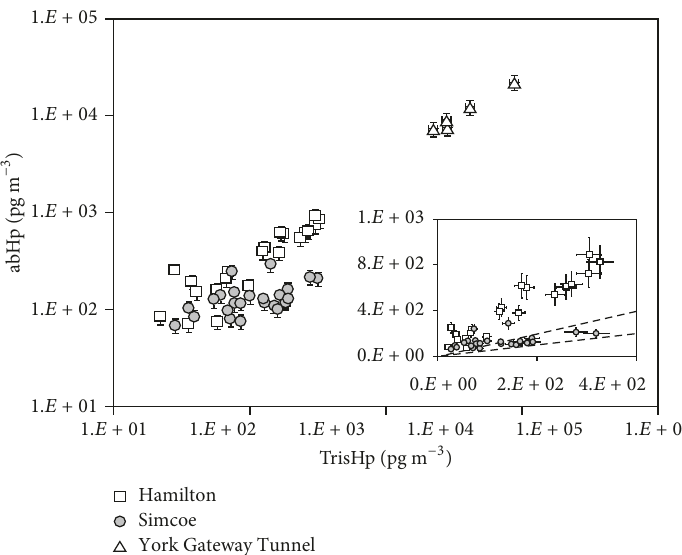
Figure 3: Scatter plot of 𝛼 , 𝛽 -hopane (abHp) concentration versus trisnorhopane (TrisHp) concentration in PM 10 collected at three different locations. The figure is in logarithm scale, and the inset is in expanded linear scale. The linear regression slopes for the Hamilton, Simcoe, and York Gateway Tunnel samples are 2.6 ± 0.1 ( 𝑟 2 = 0.884), 0.89 ± 0.09 ( 𝑟 2 = − 0.579), and 2.7 ± 0.1 ( 𝑟 2 = 0.953), respectively. Dotted lines shown in the inset are y = x and y = 0.5x, corresponding to the highest and the lowest ratios of 𝛼 , 𝛽 -hopane emission rate to trisnorhopane emission rate for coal combustions studied [19]. Error bars shown are standard errors estimated from the replicate